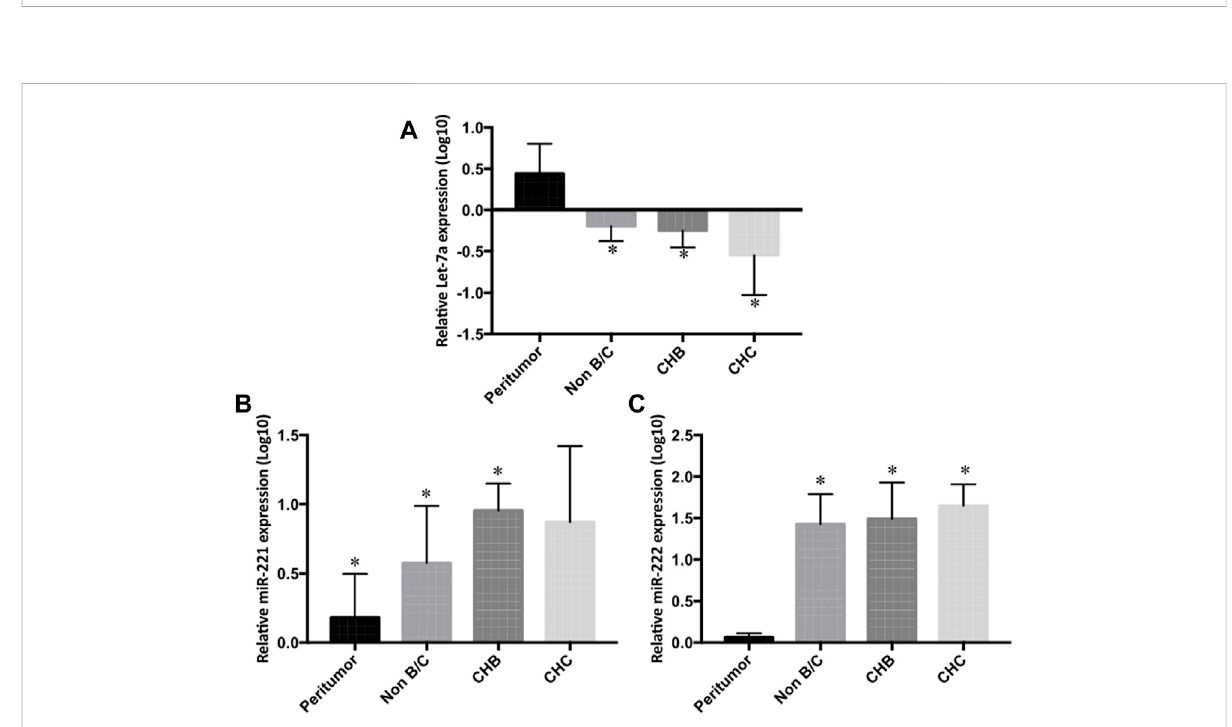
FIGURE 6 Differential tissue expression of (A) Let-7a, (B) miR-221, and (C) miR-222 in non-B/C (non-hepatitis B and non-hepatitis C), CHB (chronic hepatitis B), and CHC (chronic hepatitis C) groups compared to peritumor tissue were measured by rt-qPCR. The statistical analysis was done using Mann – Whitney test (GraphPad Prism 5.0). The statistically signi fi cant p -value was denoted as < 0.05. NS; non-signi fi